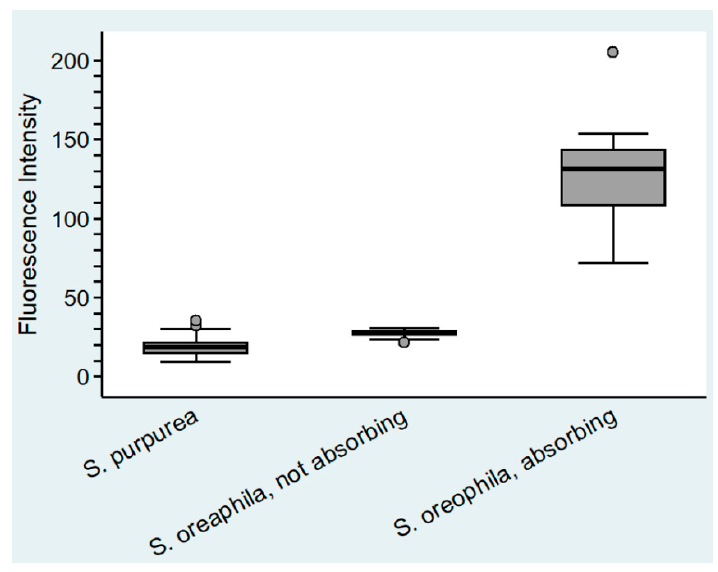
Figure 5. Fluorescent intensity in the cytoplasm of epidermal cell of Sarracenia purpurea and Sarracenia oreophila (n = 20).